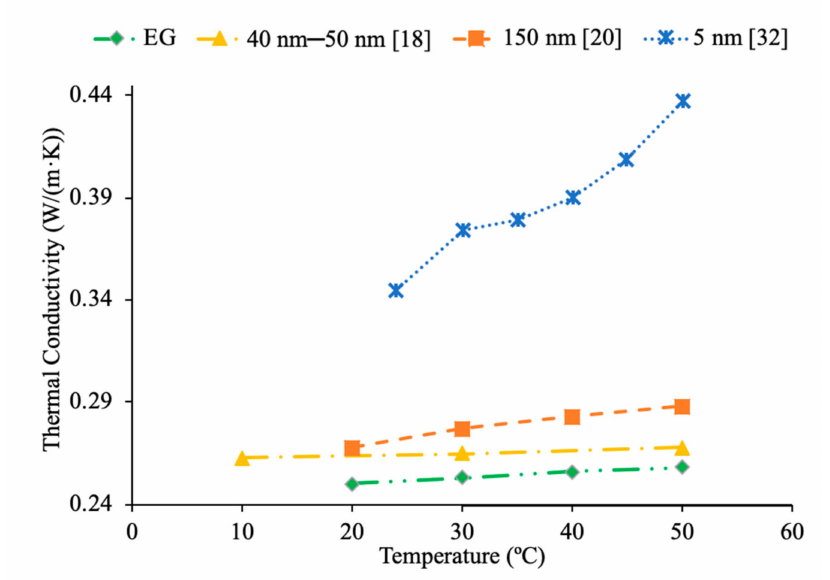
Figure 7. Al 2 O 3 –ethylene glycol (EG) nanofluids at 3% volume fraction with nanoparticle diameters of 5, 150 and 40–50 nm as a function of temperature